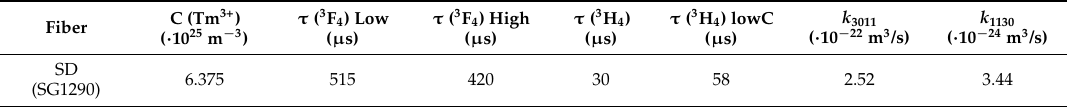
Table 3. Tm concentration in the prepared optical fiber, measured and calculated fluorescence lifetime values and calculated cross-relaxation coefficients.